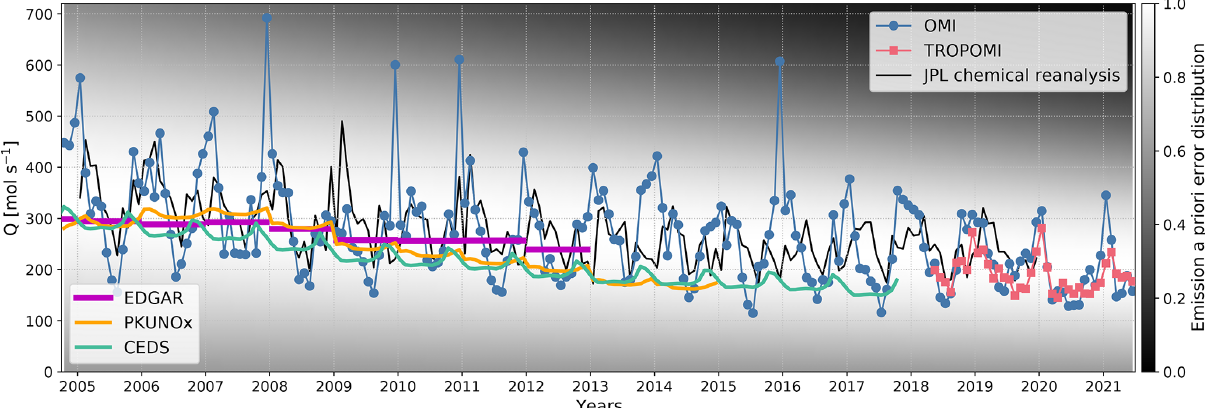
Figure 12. Po Valley NO x emission rates retrieved from OMI (blue circles) and TROPOMI (red squares) column–wind speed relationships in each calendar month. Monthly emission rates calculated from the JPL chemical reanalysis, EDGAR, PKUNOx, and CEDS inventories are shown as black, magenta, yellow, and cyan lines. The background color map indicates the prior error distributions normalized to the peak height of unity for each calendar